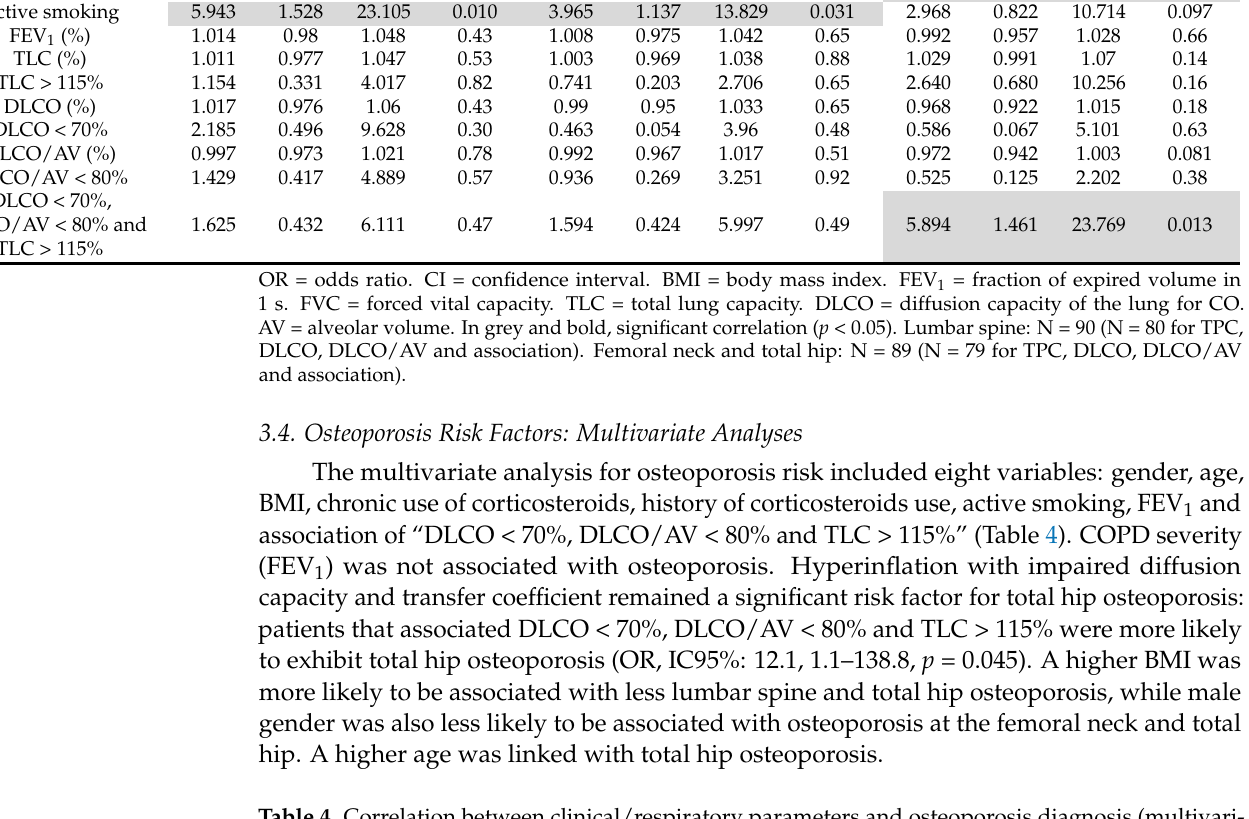
Table 4. Correlation between clinical/respiratory parameters and osteoporosis diagnosis (multivari- ate